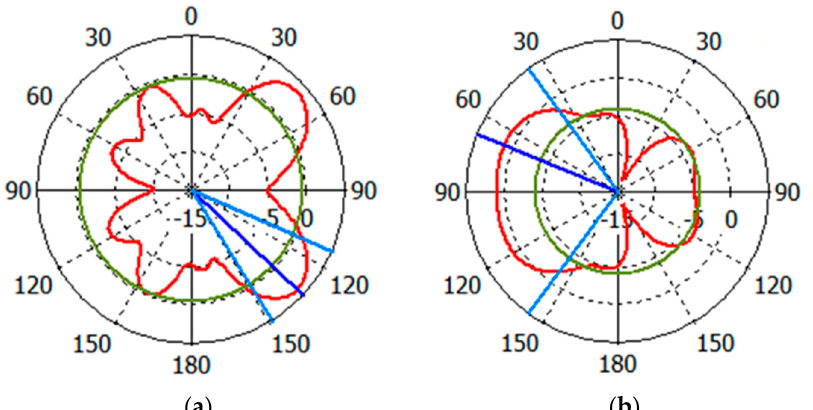
Figure 16. The radiation pattern of the bow-tie slot antenna ( a ), E-plane and H-plane ( b ).